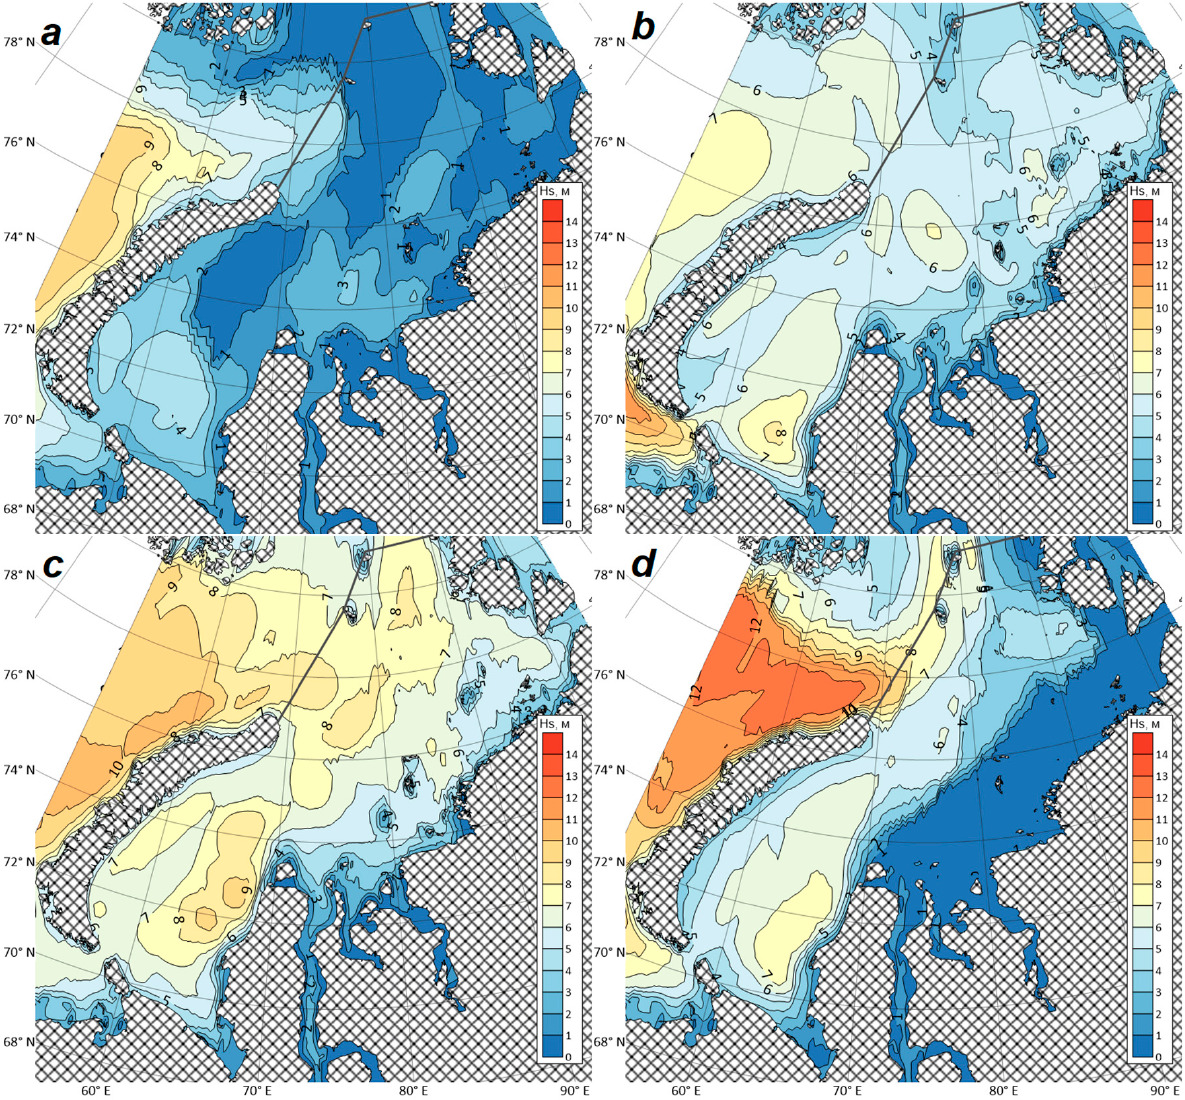
Figure 8. The maximum SWH in the Kara Sea according to the model data (from 1979 to 2017) for the periods: March– April–May (MAM) ( a ), June–July–August (JJA) ( b ), September–October–November (SON) ( c ), December–January–February (DJF) ( d ).